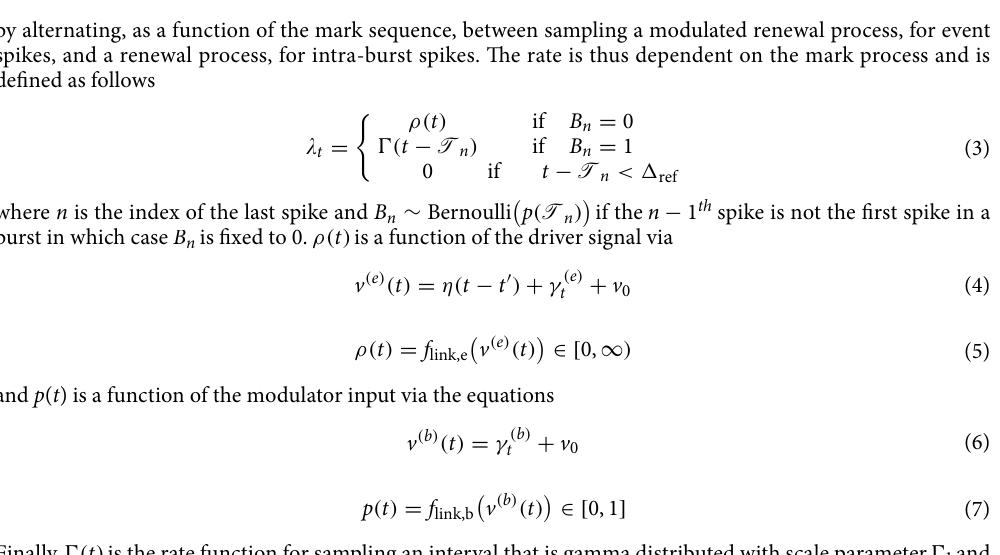
Figure Figures 3,4, 5 and 6 BSRM 10, 20 Figure 6 SRM low power 1, N/A 10, N/A Figure 6 SRM high power 10, N/A 100, Table 1. Power and timescale of the Ornstein-Uhlenbeck input signals.